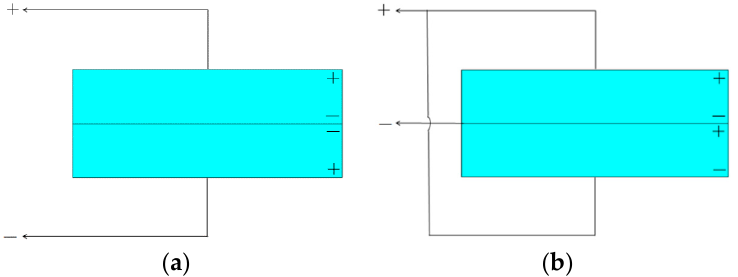
Figure 2. Schematic of the series and parallel arrangements of the piezoelectric layers. ( a ) Parallel arrangement. ( b ) Series arrangement.